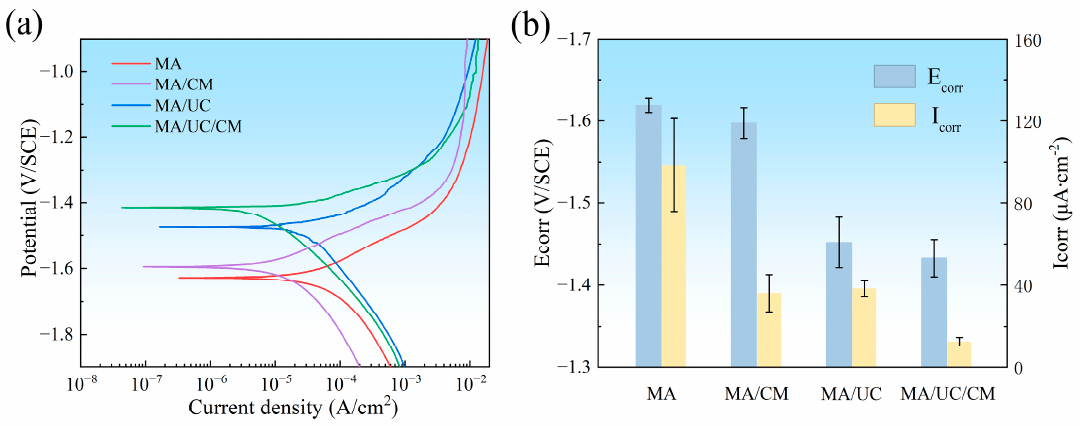
Figure 8. ( a ) Polarization curves of all the investigated samples after immersion for 1 h; ( b ) E corr and I corr calculated from the corresponding polarization curves. I corr calculated from the corresponding polarization